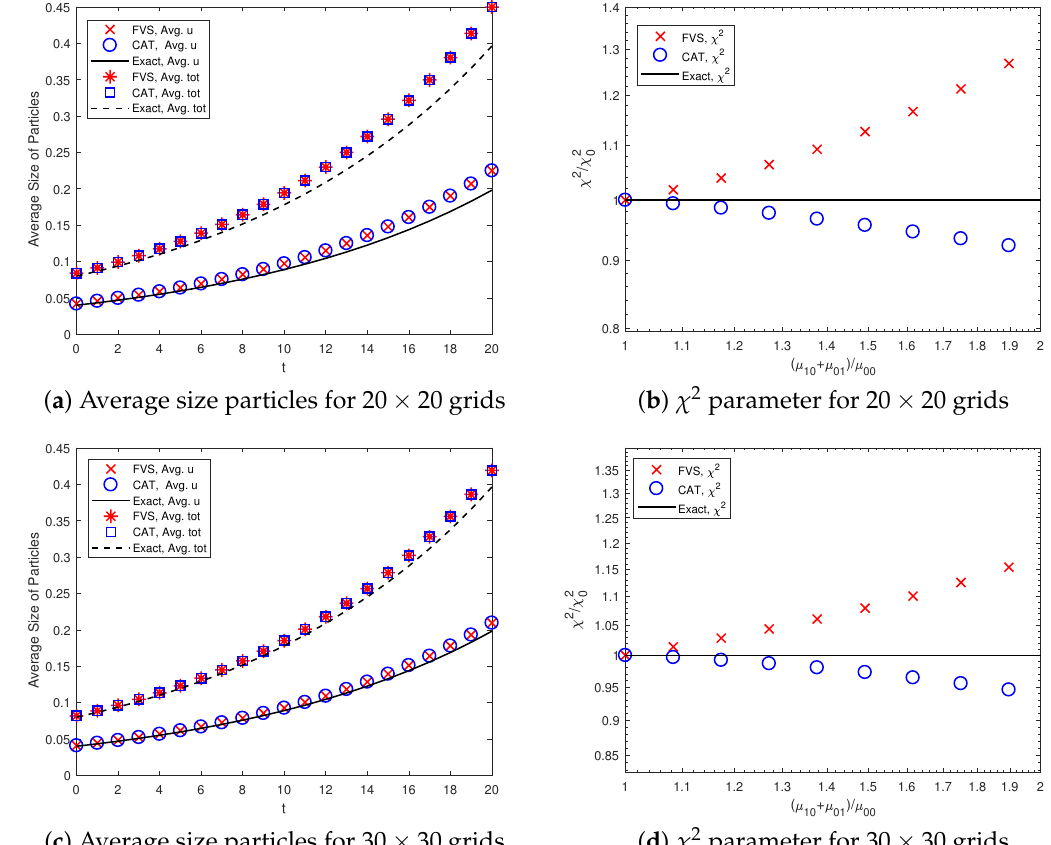
Figure 6. Average size particles formed in the system and χ 2 parameter for mixing the components using sum